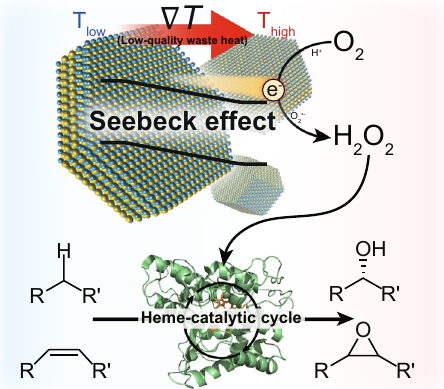
Fig. 1 Schematic illustration of a thermoelectrobiocatalytic Bi 2 Te 3 / r Aae UPO cascade for selective oxyfunctionalization reactions. Thermoelectric Bi 2 Te 3 particles drive oxygen reduction reaction to generate H 2 O 2 with applied temperature difference. Unspeci fi c peroxygenase catalyzes various selective aerobic oxygenation reactions by utilizing in situ generated H 2 O 2